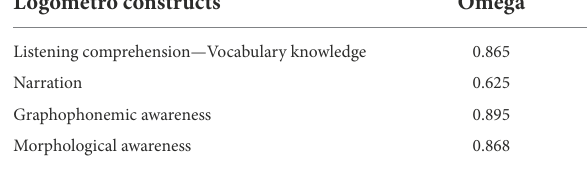
TABLE 8 Internal consistency reliability using McDonald’s omega